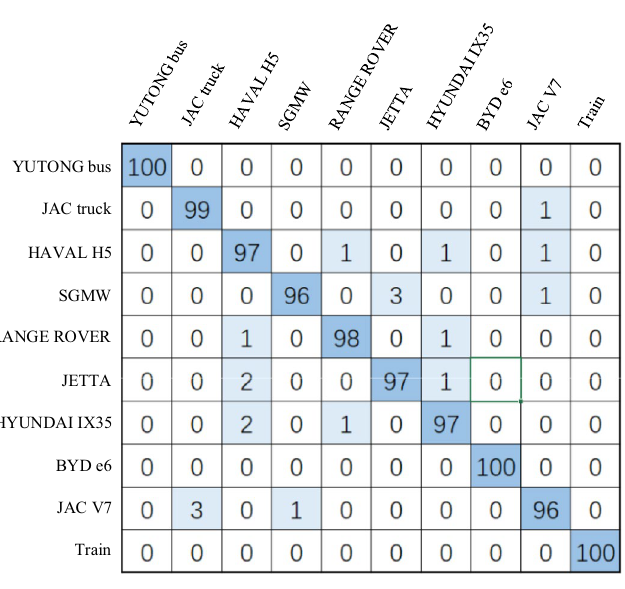
Figure 9. The confusion matrix of the